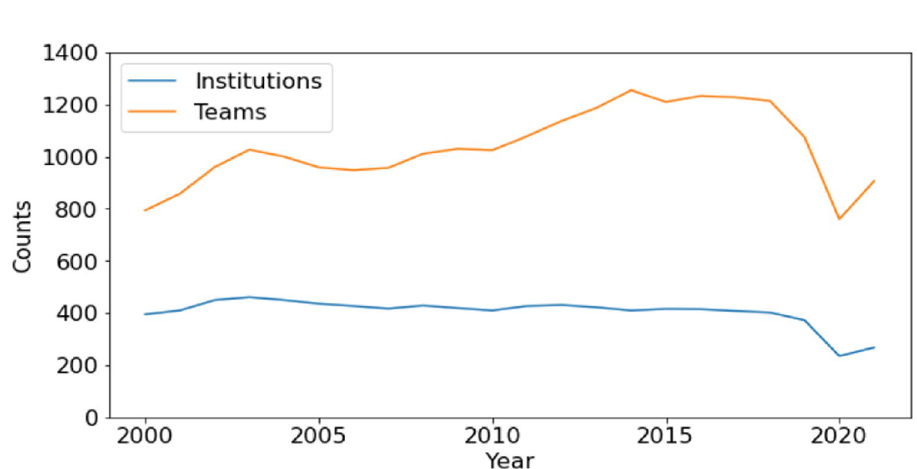
Fig. 1 Number of teams and institutions participating